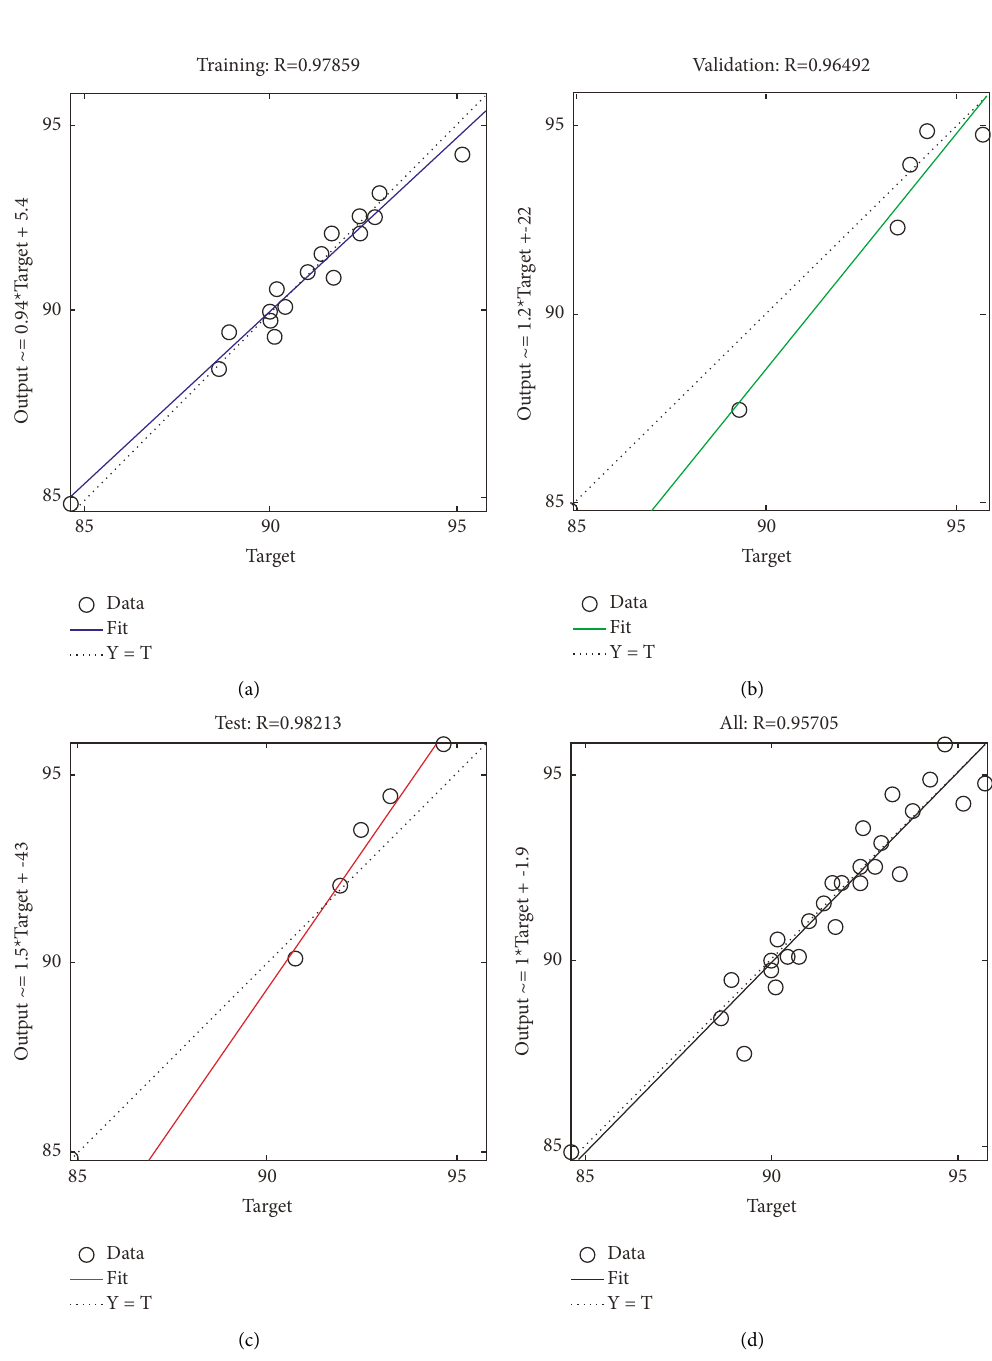
Figure 7: Output of the ANN model: (a) training, (b) validation, (c) testing, and (d) complete data.